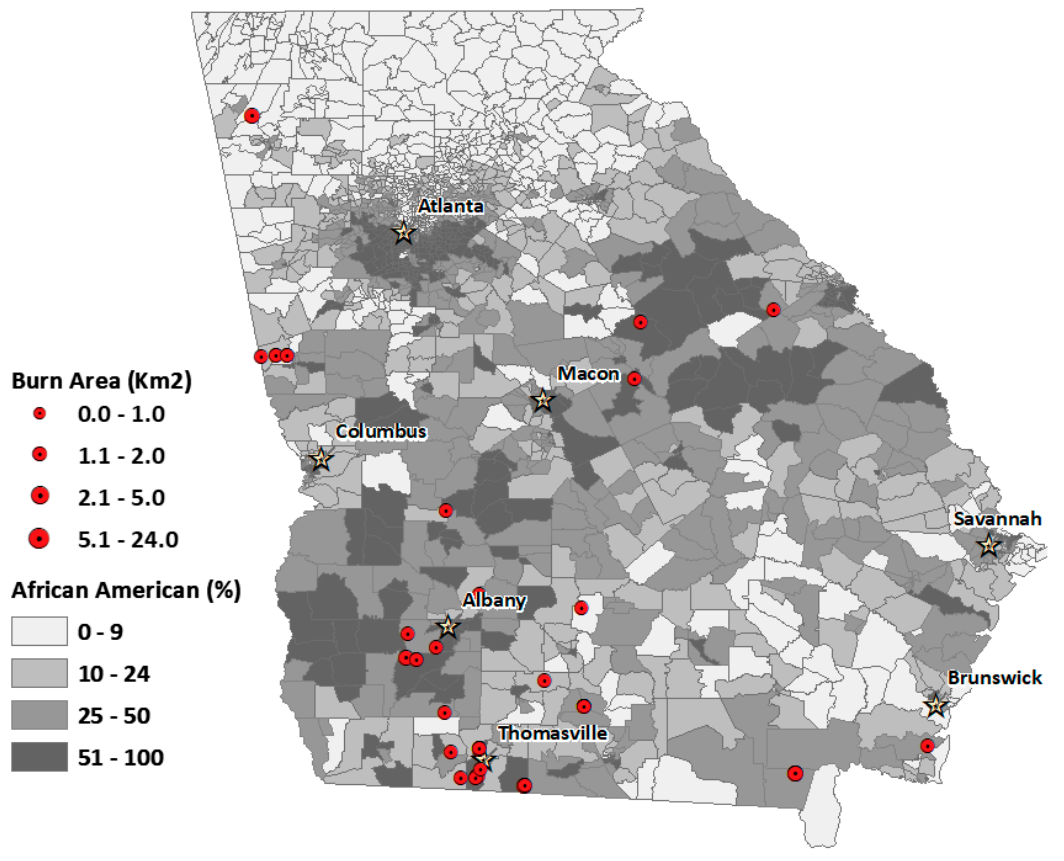
Figure 3. Spatial distribution of burn permits for conservation land exceedance days, overlaid with percent African American population for Georgia census tracts. Circles denote the relative burn area size for each